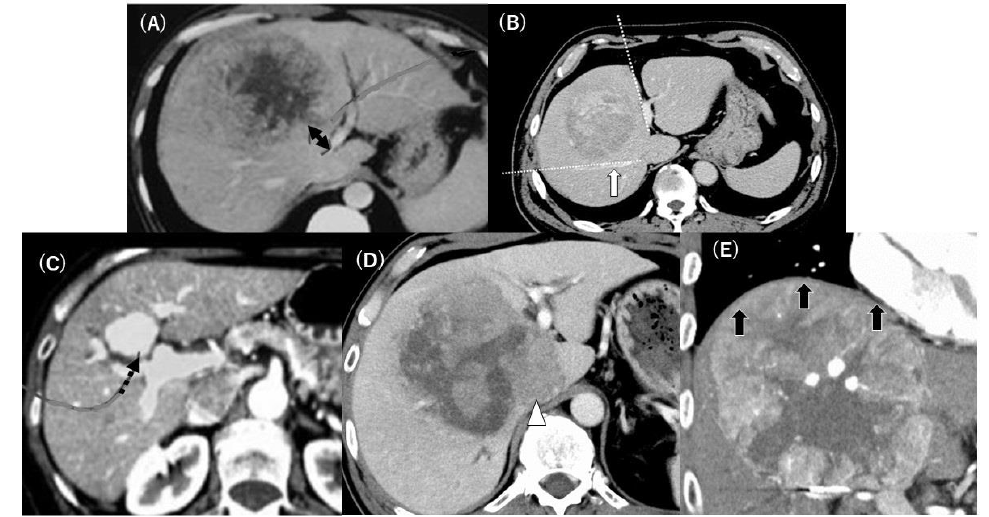
Figure 1. Inclusion criteria for collecting the cohort data of HCC patients undergoing CB (H458) from 17 expert institutions of the Kyushu Study Group of Liver Surgery as a single-arm study. CB, central bisectionectomy; HCC, hepatocellular carcinoma.